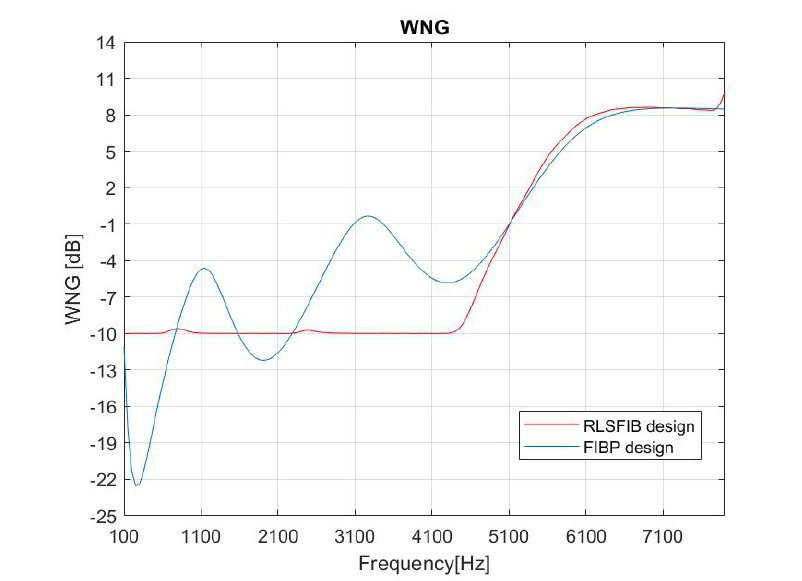
Figure 4. WNG comparison: FIBP blue, RLSFIB